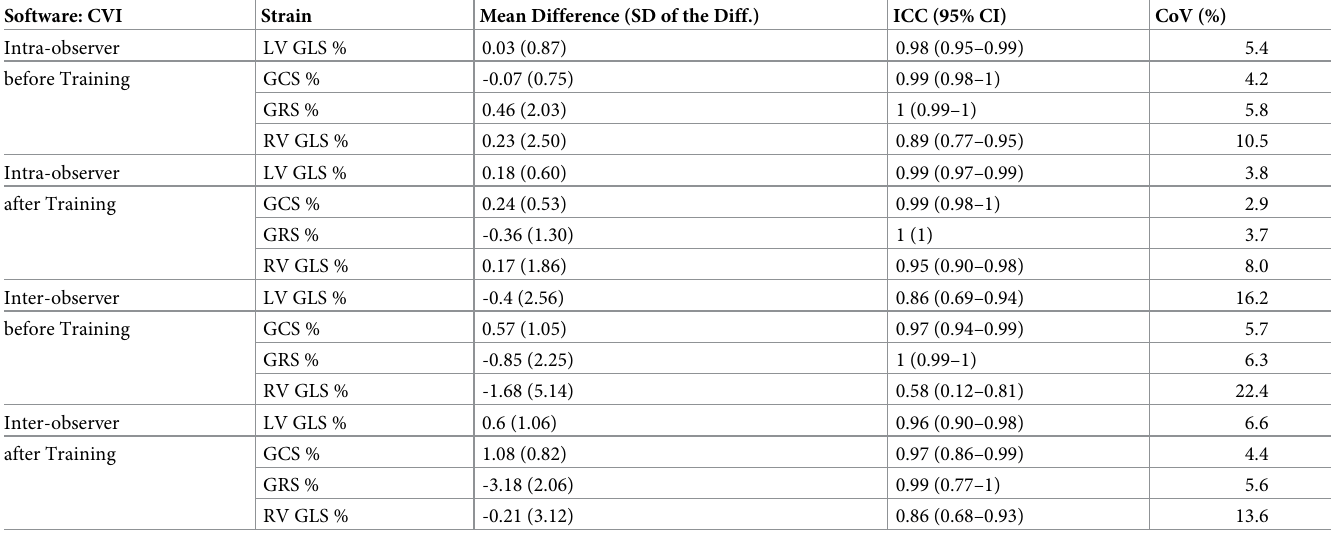
Table 2. Intra- and inter-observer reproducibility using CVI prior to and after training. Software: